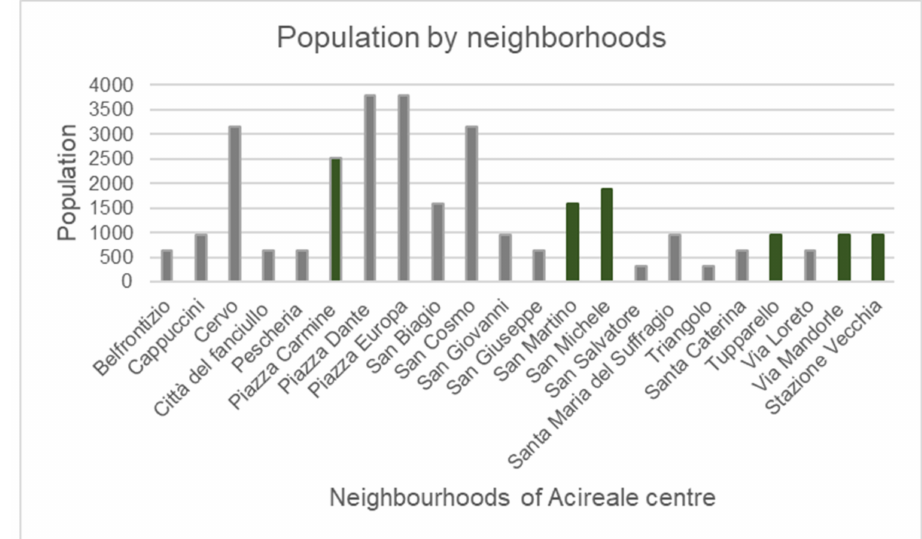
Figure 5. Distribution of population by neighbourhoods of Acireale centre (histograms in green highlight the population of the neighbourhoods directly involved in the project, those in grey the population in the other neighbourhoods of Acireale